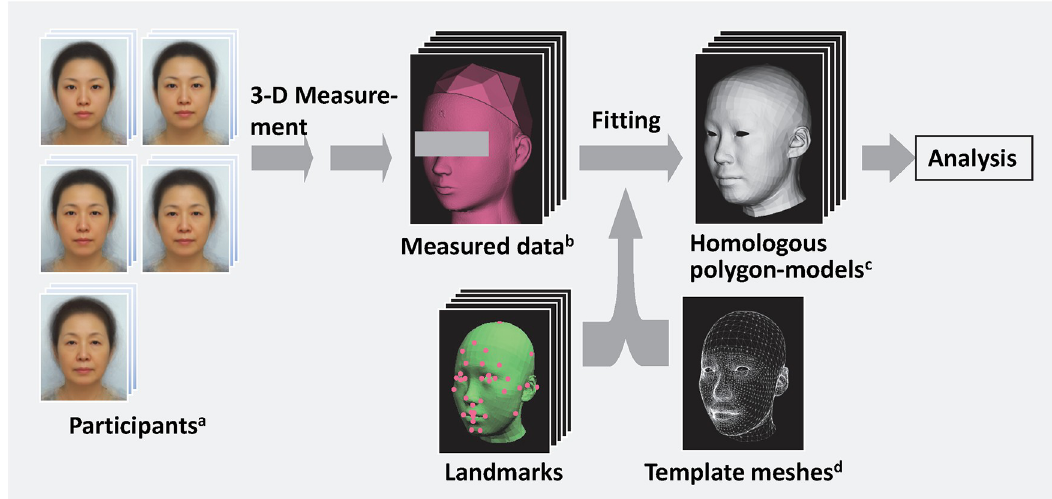
Fig 2. Schematic illustration of the three-dimensional (3D) measurements and homologous polygon modeling. a Images of averaged faces were used instead of actual participant images in this schematic illustration. b Measured data were obtained from a mannequin head instead of actual participants. c The average form of all participants was used instead of homologous polygon models of actual participants. d The Dhaiba Model was used for the template meshes.